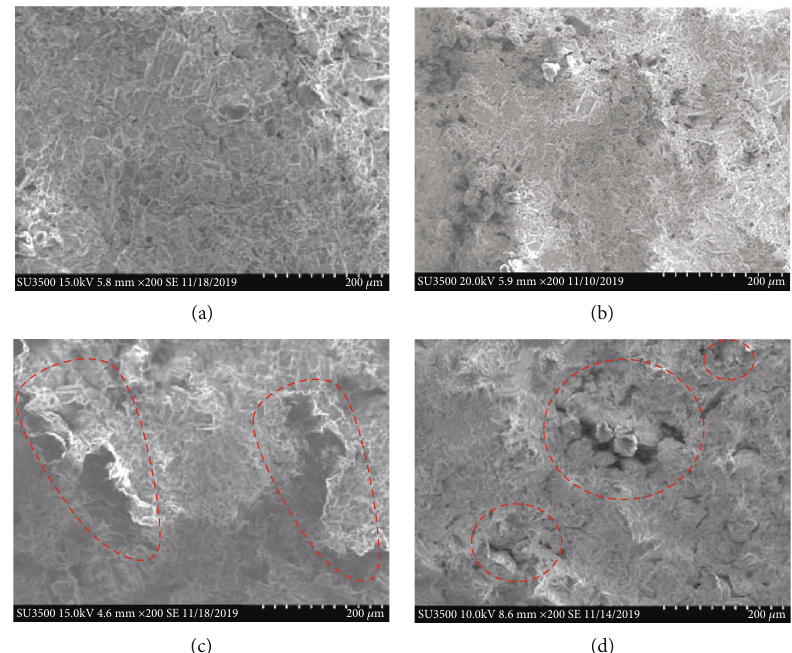
Figure 8: Enlarged microstructures of rock samples with di ff erent saturations. (a) Naturally dry condition. (b) pH = 7 . (c) pH = 6 . (d) pH = 5